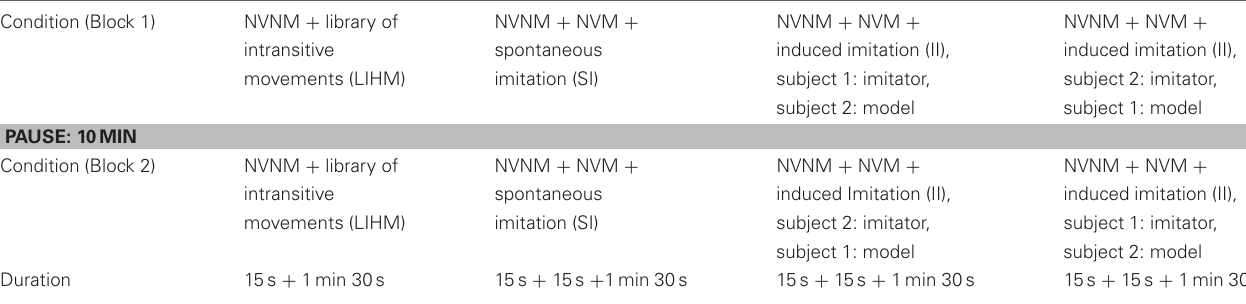
Table 1 | Experimental